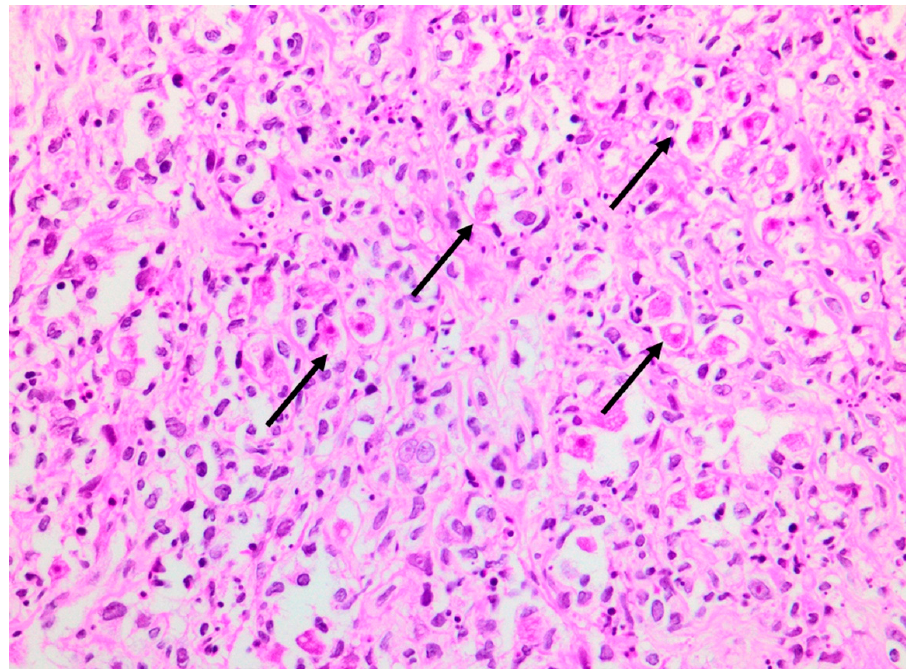
Figure 5. Photomicrograph of skin punch biopsy showing numerous amoebic organisms (arrows) and a polymorphous background inflammatory infiltrate (haematoxylin and eosin, × 400).